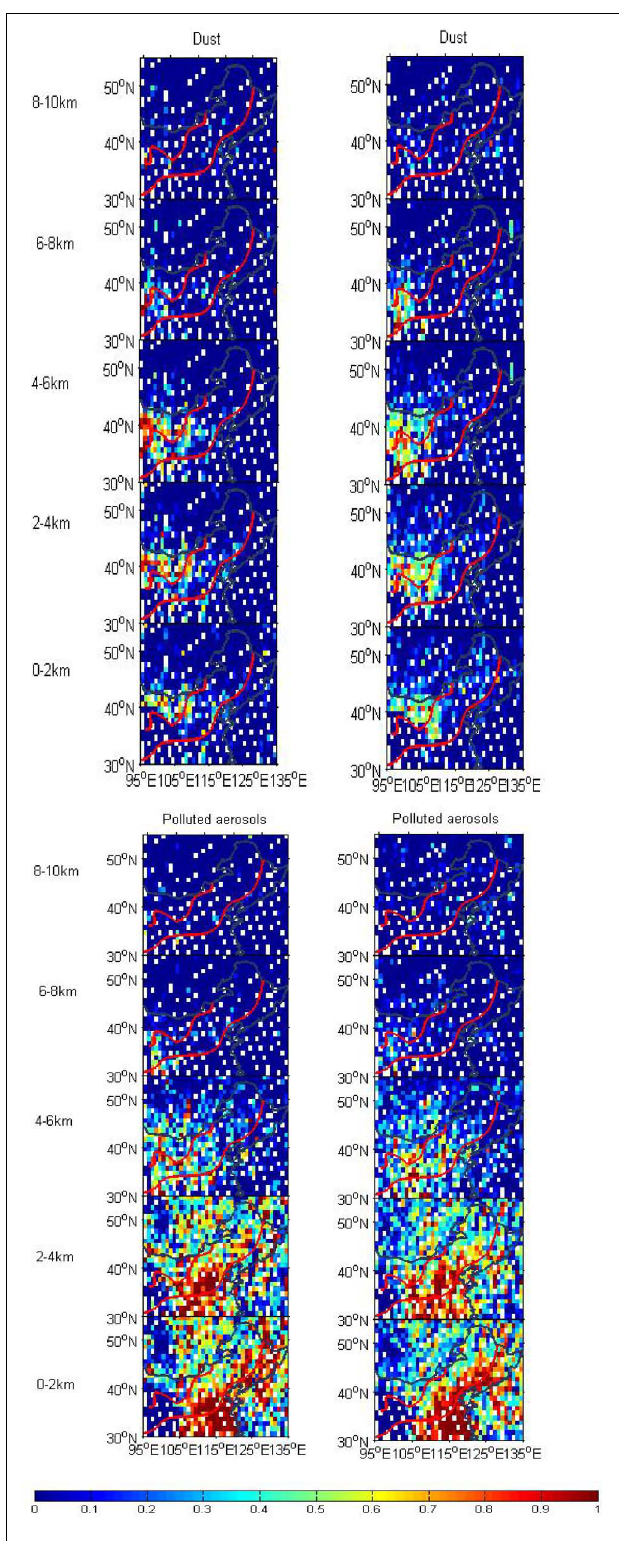
FIGURE 4 | Frequency of dust and polluted aerosols over the transition zone (red curve region) in abundant and deficient years ( Left : abundant years; Right : deficient